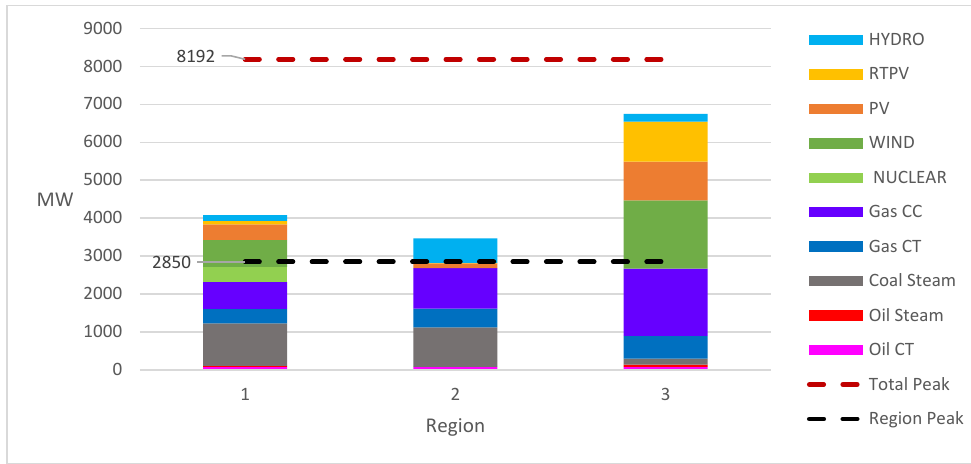
Figure 1. Installed capacity in MW per region in the RTS-GMLC. The peak load per region is the same at 2850 MW and is shown by the lower dashed line, with a total peak load of 8.2 GW shown by the upper dashed line, with a total installed capacity of 14.3 GW.